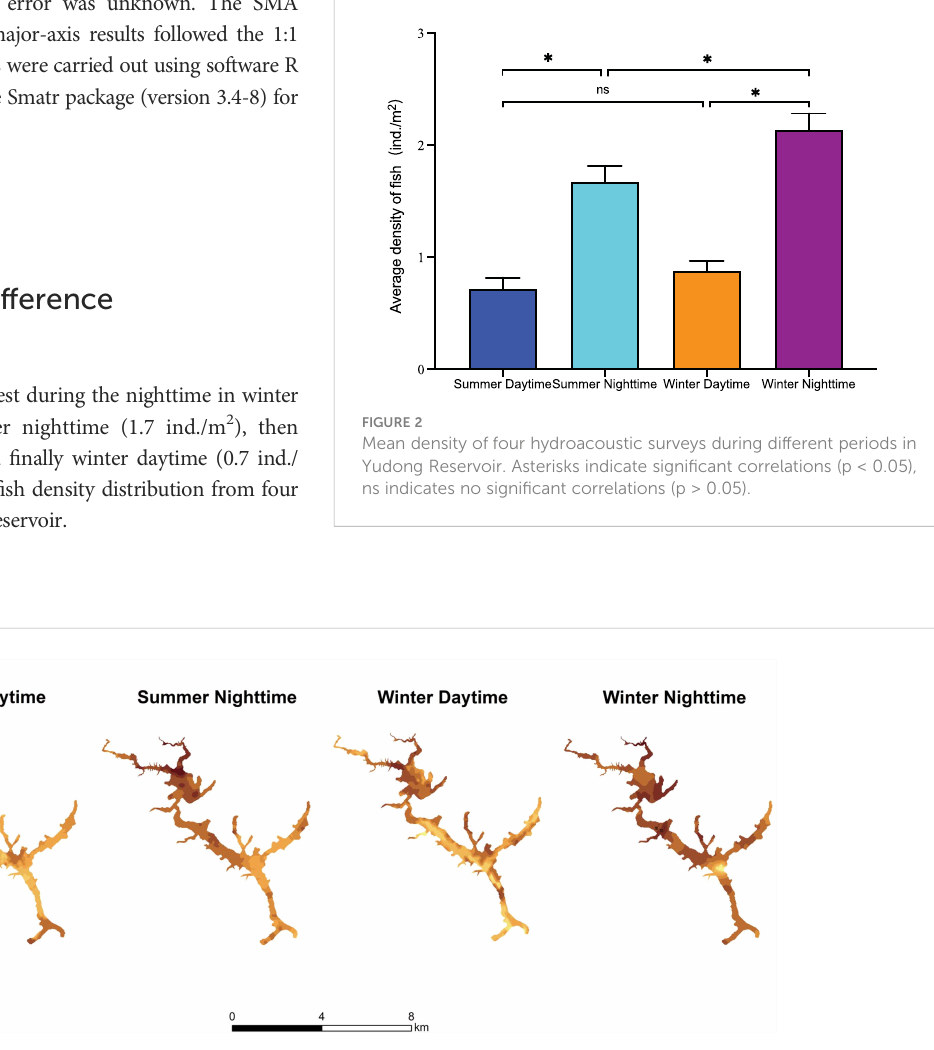
FIGURE 3 Fish density distribution from four hydroacoustic surveys in Yudong